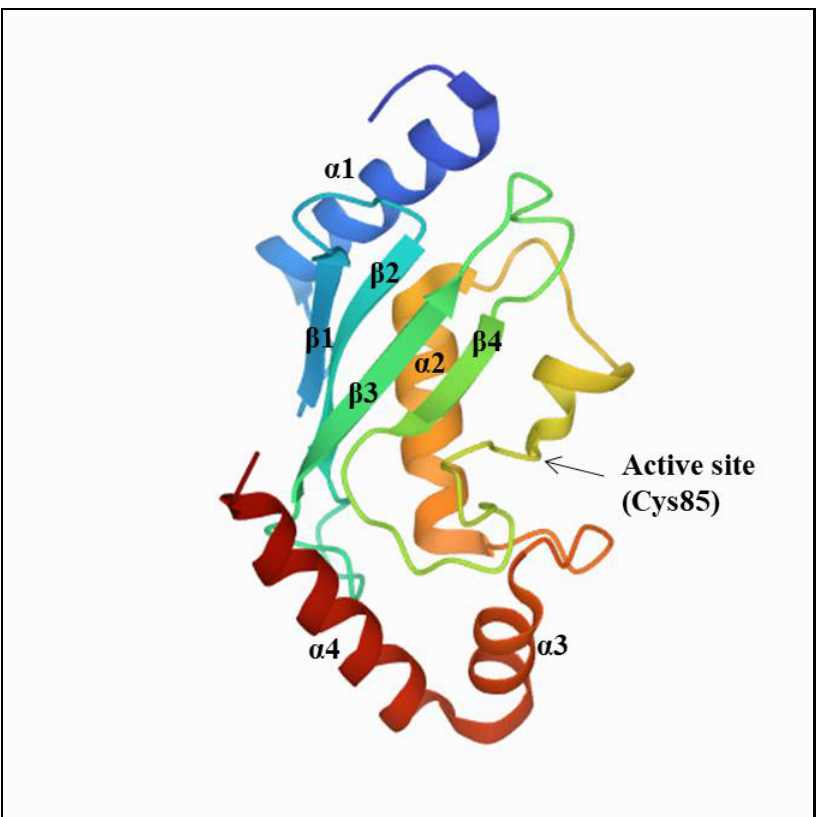
Figure 2. Structural representation of E2s. Crystal structure of human UBE2A (Protein Data Bank (PDB) code 6CYO) as a representative of the UBC fold conserved among E2s. The UBC core is typ-